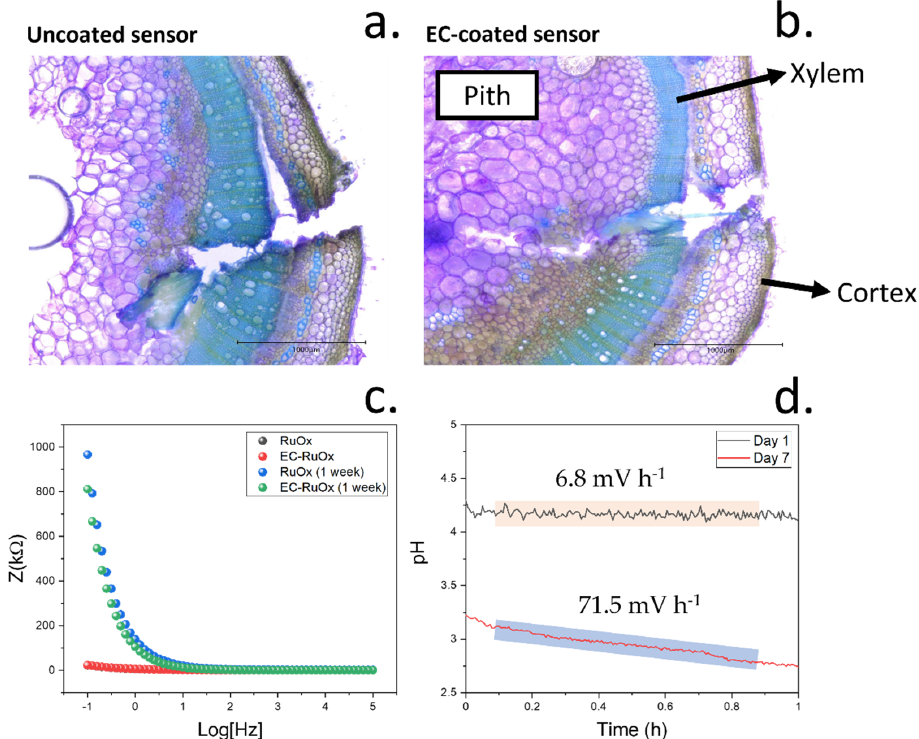
Figure 8. ( a ) Cross ‐ section image of a tomato plant stem where a pristine RuO x electrode had been inserted, evidencing the tissue damage due to the implantation. Three areas from the plant stem are clearly differentiated by the staining process used (cortex, xylem and pith). ( b ) Cross section of tomato plant stem where the cellulose coated electrode had been incorporated. The different plant tissues that can be identified are labelled. ( c ) Differences in electrical impedance obtained from pristine and cellulose ‐ coated electrodes recorded at different frequencies. The impedances on day 1 and day 7 were measured and compared. ( d ) Continuous monitoring of pH in tomatoes on day 1 and day 7, evidencing the increase in signal drift due to the plant healing process.